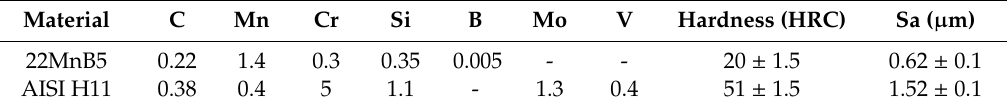
Table 1. Chemical composition (in wt%), hardness (room temperature), and surface roughness of the blank and tool in the as-delivered